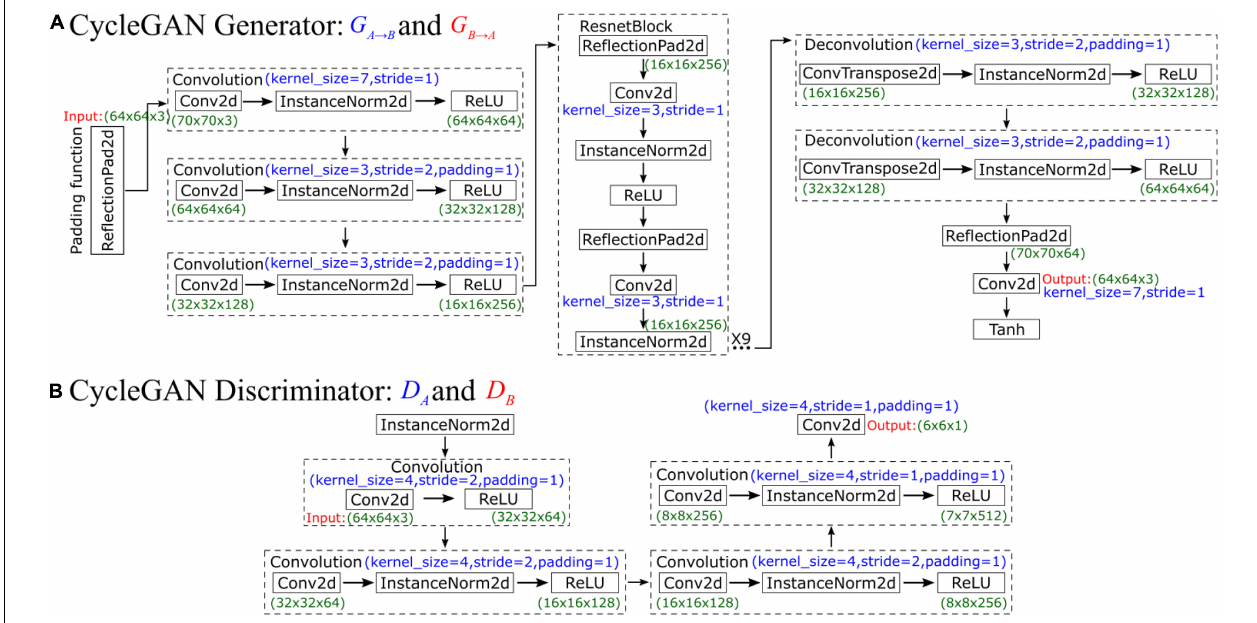
FIGURE 3 | Schematic diagram showing the (A) generator and (B) discriminator of CycleGAN.